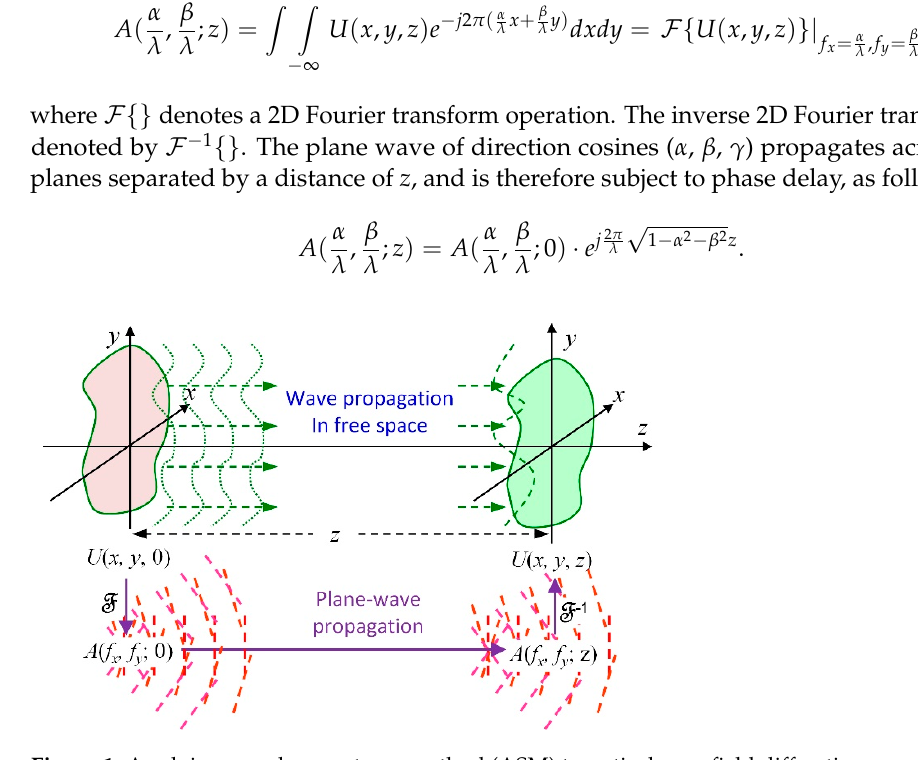
Figure 1. Applying angular spectrum method (ASM) to optical near-field diffraction.